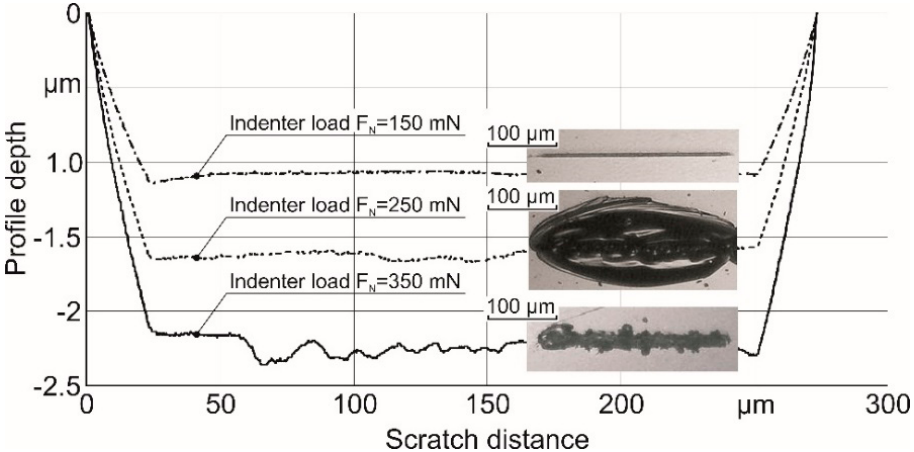
Figure 8. Scratching sclerogramm and micro photos of short scratches in the quartz glass.